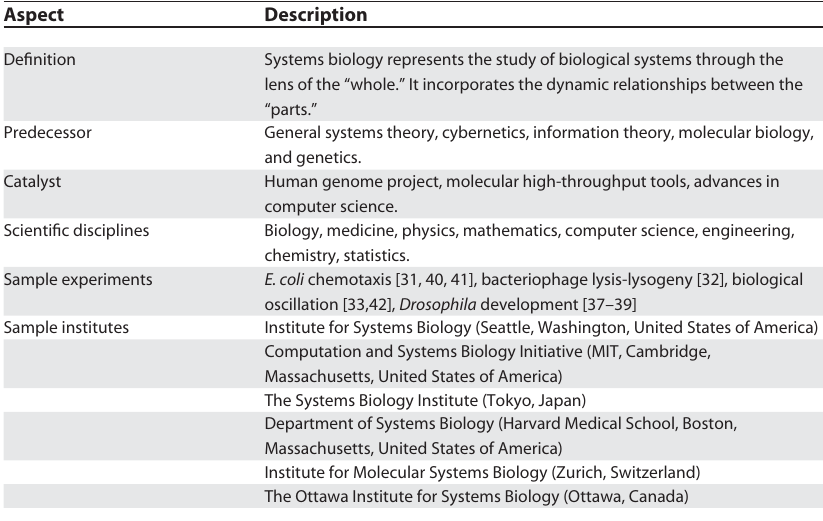
Table 2. Overview of Systems Biology